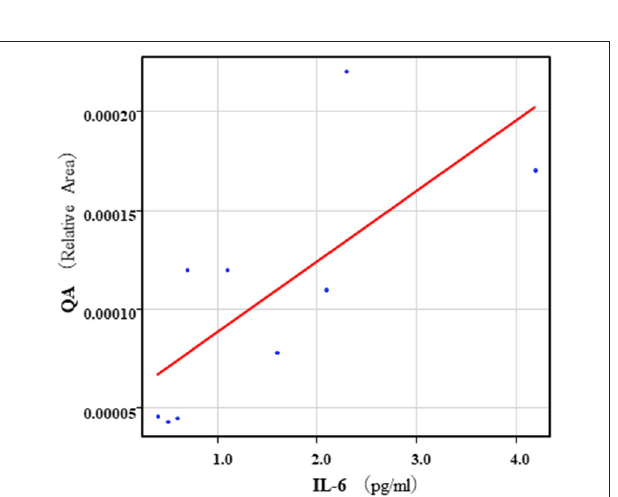
FIGURE 6 | Association between serum IL-6 levels and serum QA levels in the healthy control group. A positive correlation was found between the serum IL-6 levels and the serum QA levels ( r = 0.78, p = 0.010) in the healthy control group. Relative Area: The peak areas of the metabolites were normalized against those of the internal standards, and the resultant relative areas were further normalized by the sample amount explained in the Measurement of metabolites of the Kyn pathway. Thus, serum QA levels demonstrated as the ratio comparing with internal